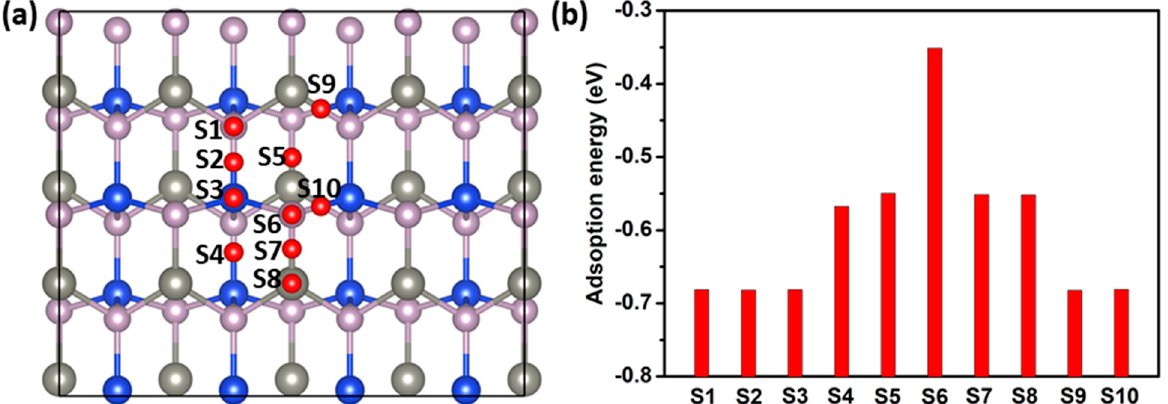
Figure 5. ( a ) S1-S10 are the possible adsorption configurations of K ions on the ZnSiP 2 monolayer. ( b ) Adsorption energies of K ions at each location. ( b ) Adsorption energies of K ions at each location.